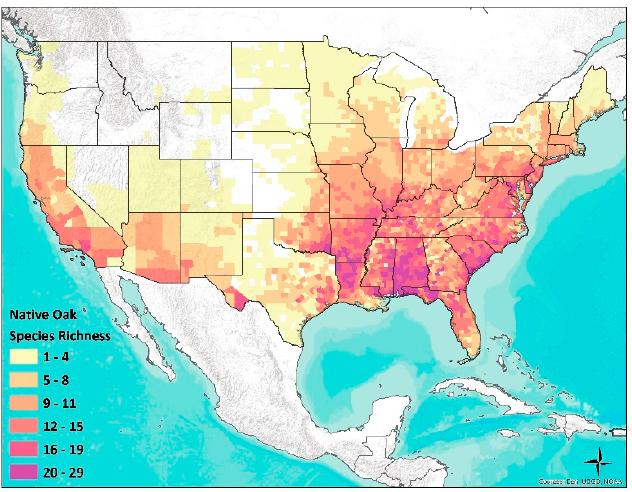
Figure A1. Native U.S. oak species richness by county. County level distribution data from USDA PLANTS and Biota of North America Program (BONAP) were combined to estimate species richness. Table A1. The matrix of rarity as presented by Rabinowitz mapped with three rare oaks ( Q. boyntonii, Q. georgiana, and Q. oglethorpensis ) and three oaks which are common by two measures (geographic range and habitat) but rare in abundance ( Q. hemisphaerica, Q. incana, and Q. laevis ). The three rare species group together in the same rarity ranking, while the three common oaks group together in a different rarity ranking. Bold font indicates species is in the subgenus Erythrobalanus (red oak), regular font indicates species is in the subgenus Leucobalanus (white oak). Geographic Range